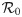
The potential basic reproductive numbers in the r- and K-strategies.This figure illustrates R0 for both strategies in the absence of density effects. The horizontal axis shows the ratio of the strength in the intraspecific competition (κ), and the vertical axis represents R0 under Γt = 0. The solid and the dashed lines represent the same entities as those in Fig 3, and the parameters used are also the same. It is shown that the K-strategy of R0 is not always higher than the other. Therefore, the basic reproductive number of the K-strategy potentially depends on the ratio of the strength in the intraspecific competition.